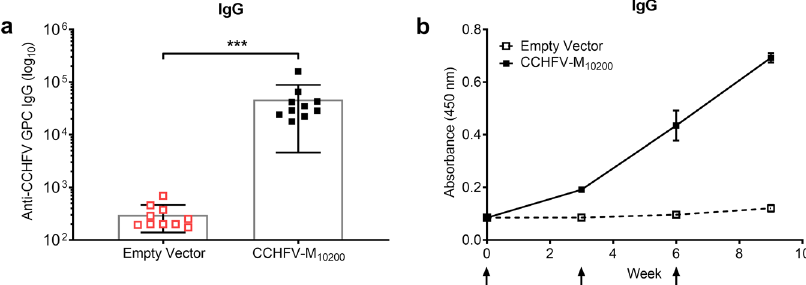
Fig. 2 CCHFV-M 10200 DNA vaccination elicits CCHFV-IbAr 10200 speci fi c antibodies. Groups of 10 female C57BL/6 mice were vaccinated with 50 μ g CCHFV-M 10200 or empty vector on days 0, 21, and 42 by IM-EP. a CCHFV-IbAr 10200-speci fi c antibody responses were analyzed 21 days post third vaccination for ELISA endpoint titers. Mice that succumbed to challenge are highlighted red. b Temporal anti-CCHFV-IbAr 10200 IgG responses in vaccinated mice. The arrows indicate DNA vaccination time points. Data are the group mean averages ± SD. *** p < 0.001. The endpoint titer p value was determined by Student ’ s t test with a 95% con fi dence